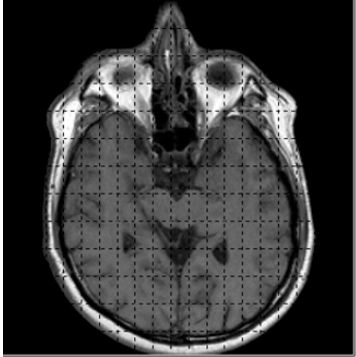
Figure 7. The input image with 128 × 128 segments.